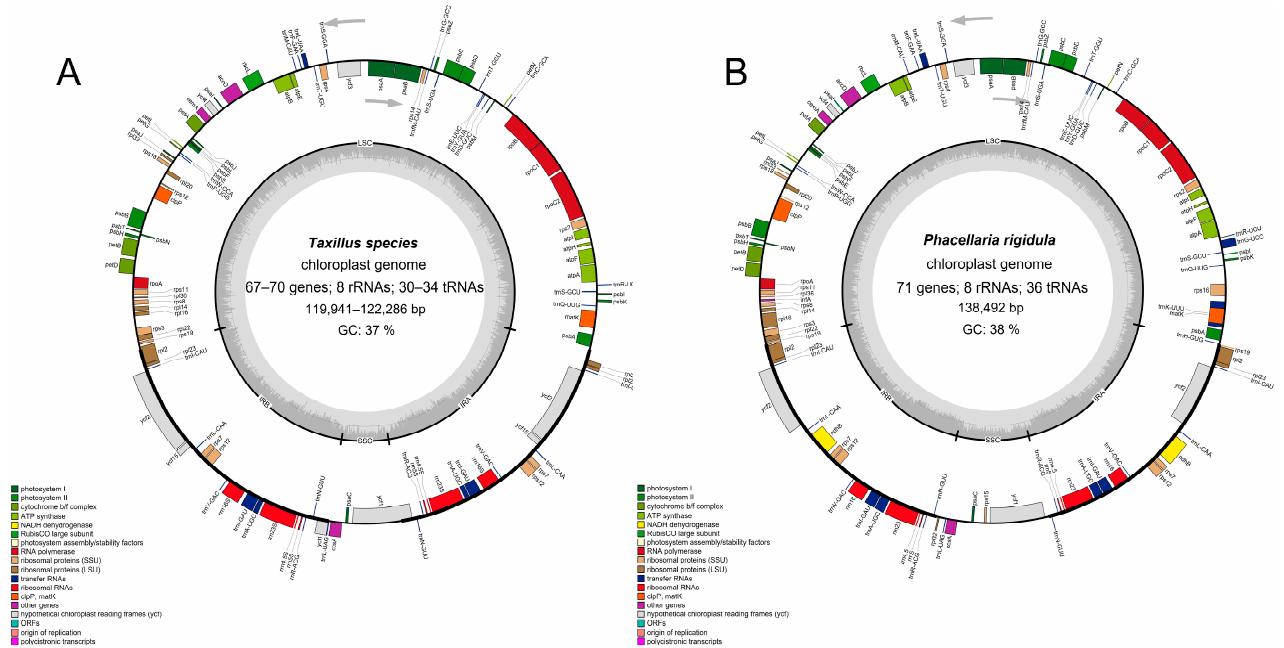
Figure 1. ( A ) Chloroplast genome map of Taxillus species, using T. chinensis as the template. ( B ) Chloroplast genome map of P. rigidula . The grey arrows indicate the direction of transcription of genes. Genes in the inner circle are transcribed in a clockwise direction, while those in the outer circle are transcribed counter-clockwise. The varying shades of gray in the inner circle indicate the distribution of GC and AT content, with darker shades corresponding to GC content and lighter shades corresponding to AT content.